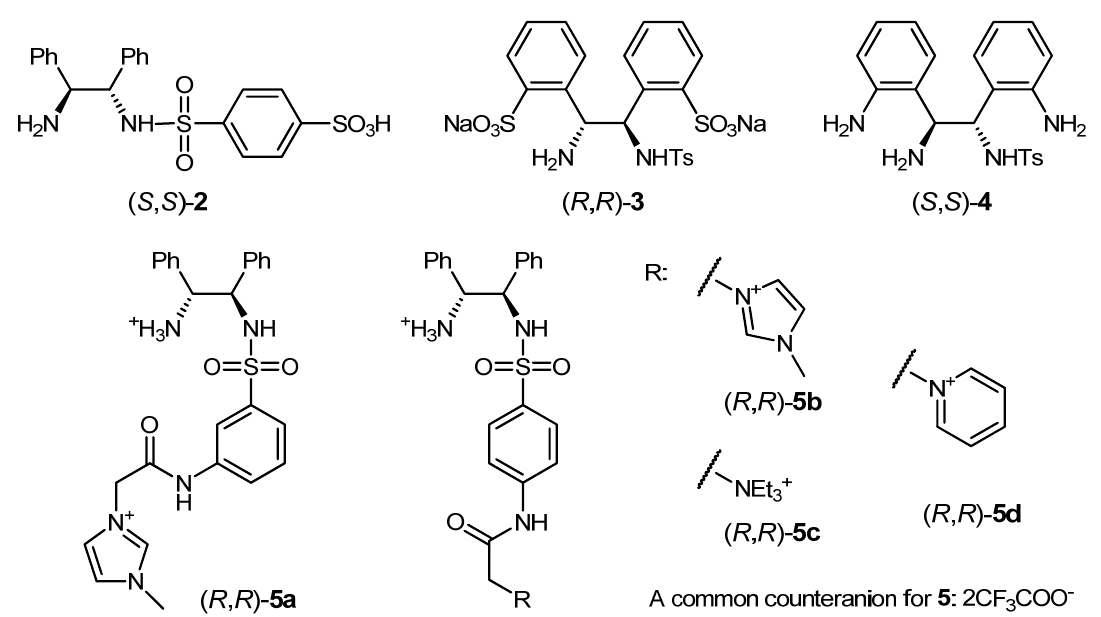
Figure 2. Modifications of TsDPEN used in ATH in